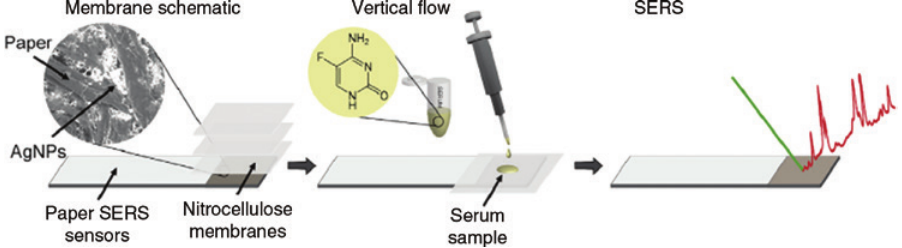
Figure 6: Working principle of a point-of-care applicable platform for SERS based on a paper-filtering membrane. The micro-structure is visible in the SEM picture of the Ag NPs on cellulose paper. After application of the sample liquid, proteins are separated from the active ingredients by vertical flow filtering. The SERS signal of the analytes can then be read from the paper SERS sensor. Adapted from Berger et al. [79], reproduced with the kind permission of Elsevier, Copyright (2017)